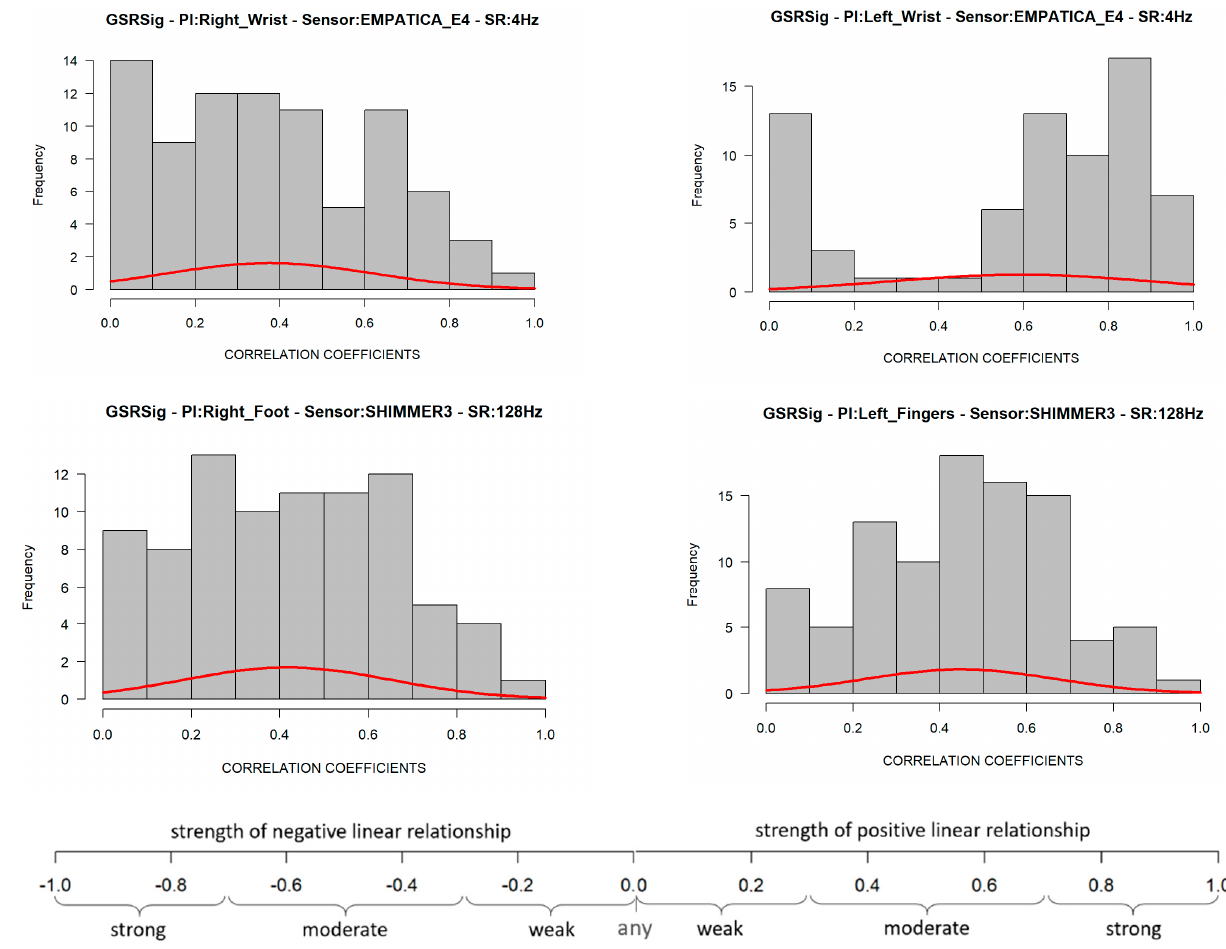
Figure 5. Distribution of positive correlations from the correlation matrices of each GSR signal. The bottom part is the strength of the association scale of Pearson’s correlation coefficient.